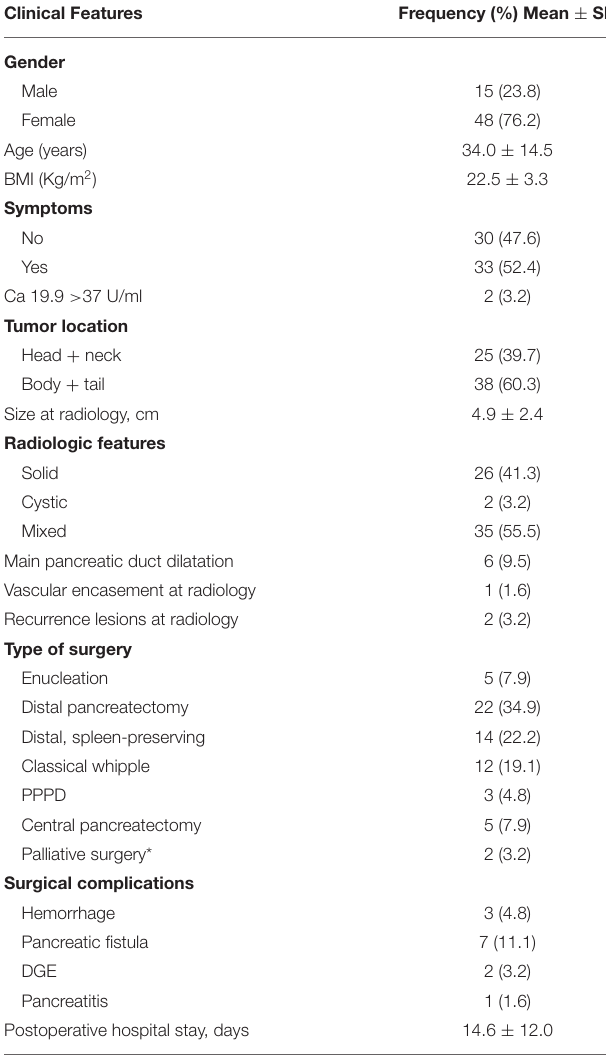
TABLE 2 | Pathological features of the 63 resected SPN (at primary tumor operation). Clinical